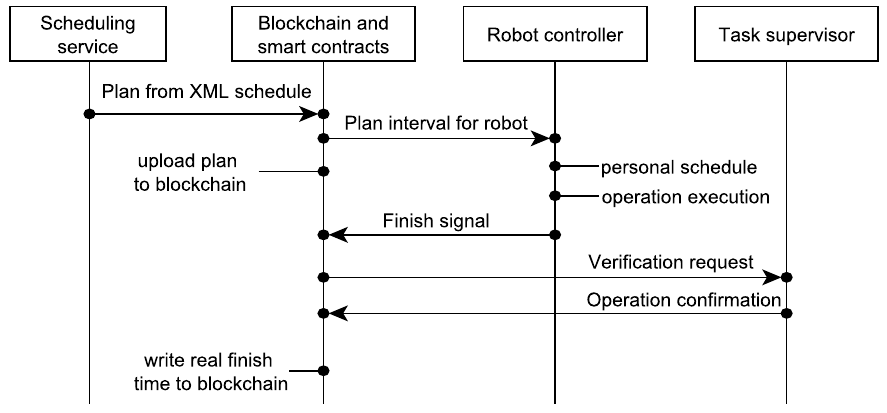
Figure 5. Process for